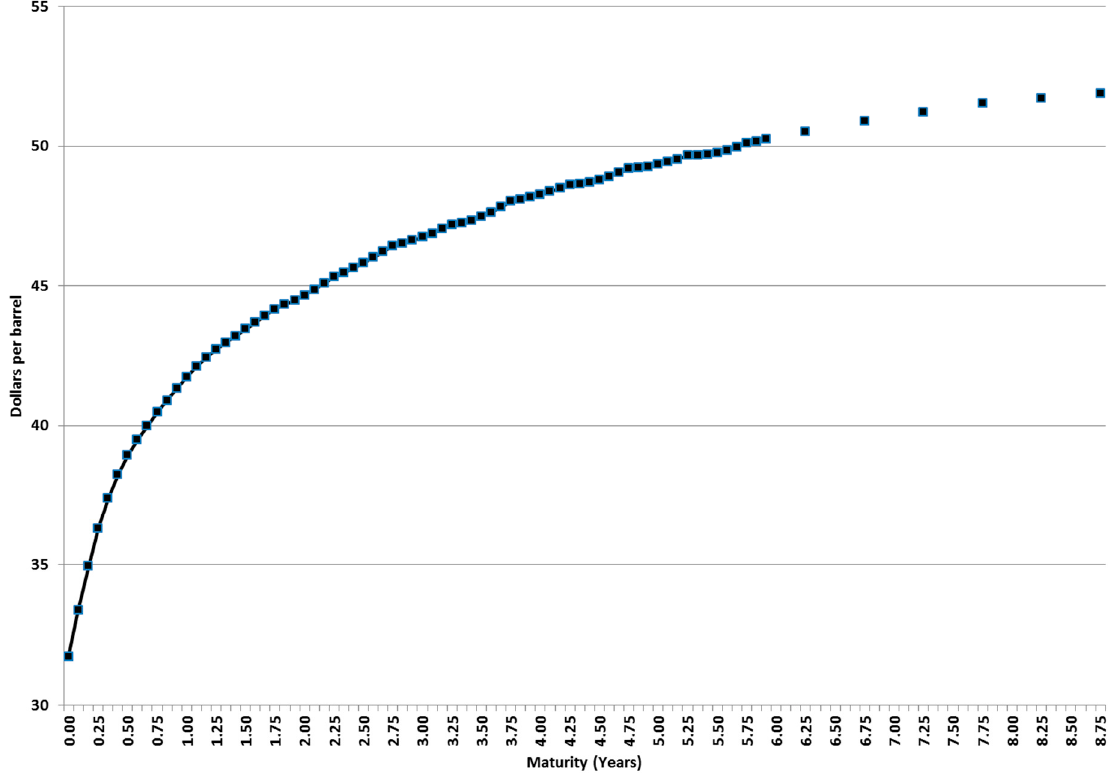
Figure 3. ICE WTI futures price curve (4 February 2016, the last sample day). Source: ICE.